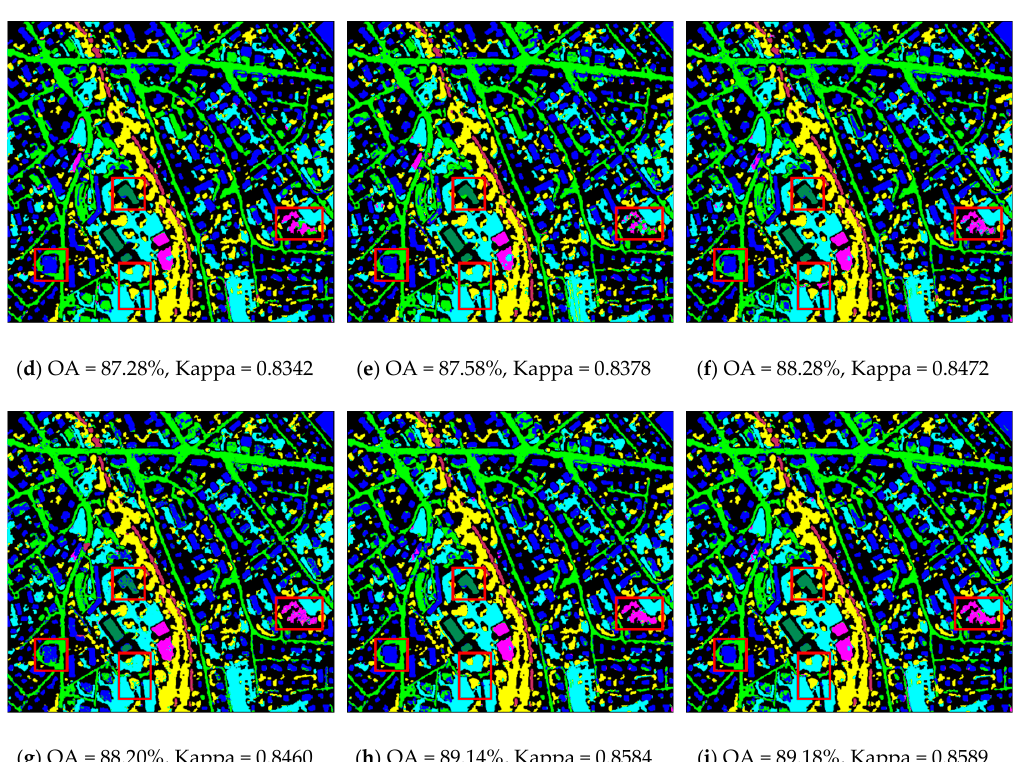
Figure 15. Classification maps (and the close-up figures in the red boxes) obtained by: ( a ) original bands; ( b ) SLIC Raw (when S = 15); ( c ) PGF (with r = 4); ( d ) SGF (with r = 5); ( e ) GF Prob (with r = 6); ( f ) MPGF (with r = [1,25]); ( g ) EMPs (with r = [1,25]); ( h ) the proposed MSGF (with r = [1,25]); ( i ) the proposed FS-MSGF (with r = [1,25] and F = 30) (Zh2). Table 3. Classification results of Zh2 obtained by the proposed and reference methods.